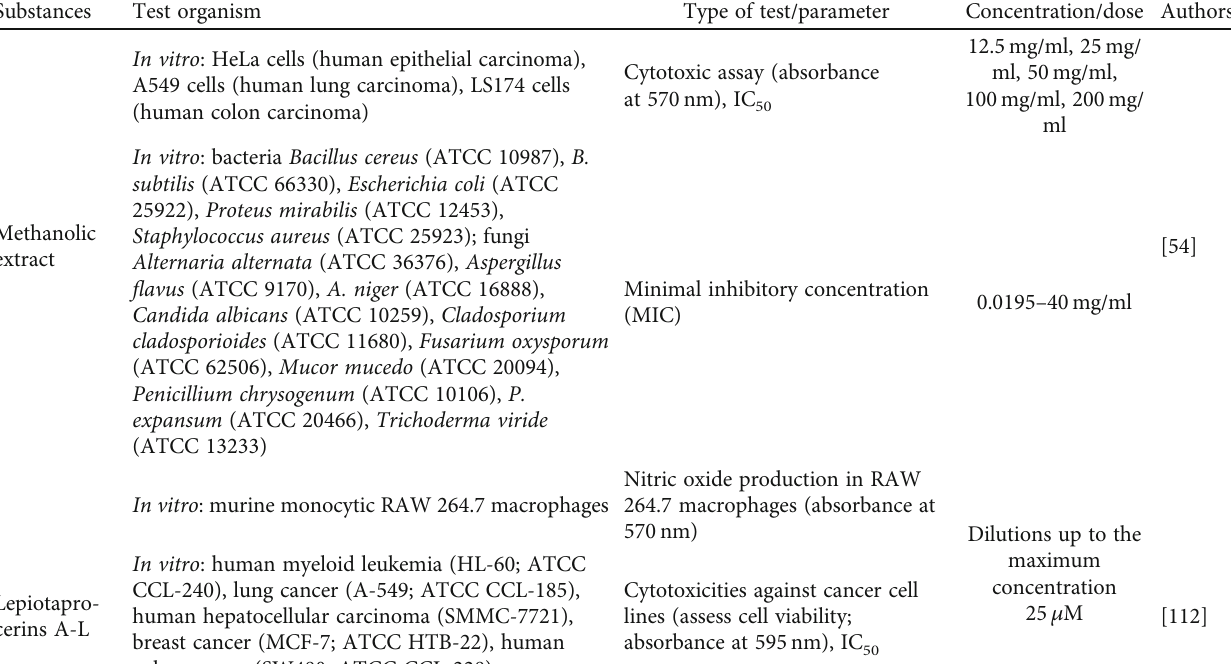
Table 4: Studies on the use of substances contained in Macrolepiota procera for medical purposes (from 2015 to 2021). Substances Test